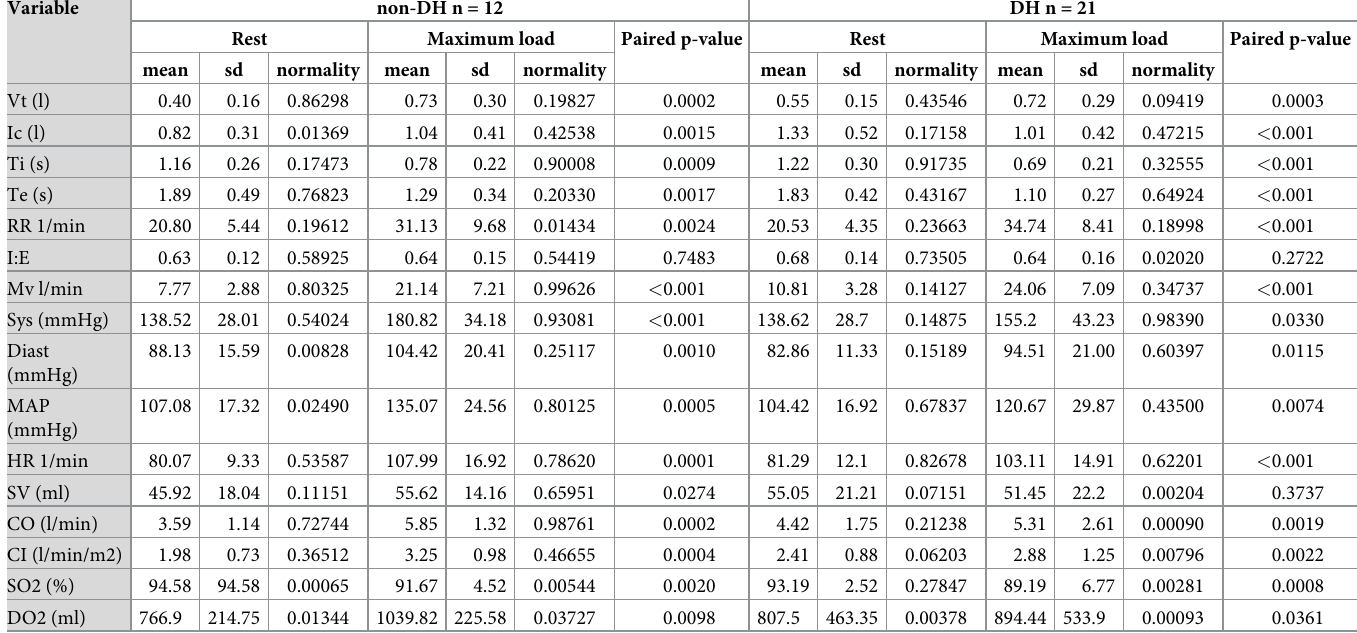
Table 2. Respiratory volumes, breathing patterns, cardiovascular parameters, oxygen saturation, oxygen delivery and left ventricular ejection time index by DH and non-DH